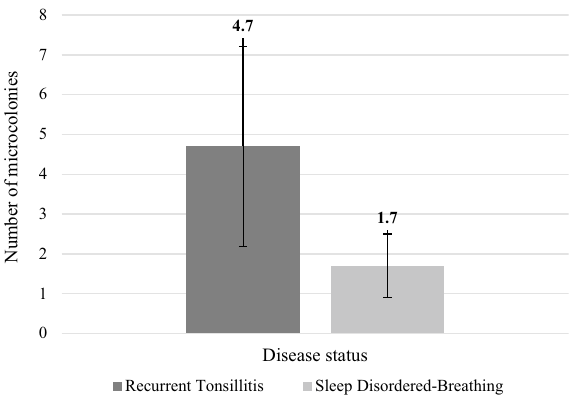
Figure 4. Number of bacterial microcolonies found per patient according to diagnosis. In total, 344 microcolonies were observed in 14 recurrent tonsillitis patients (4.7 ± SD 2.5 on average per person). In total, 24 microcolonies were observed in 10 sleep disordered-breathing patients (1.7 ± SD 0.8 per person) ( p =